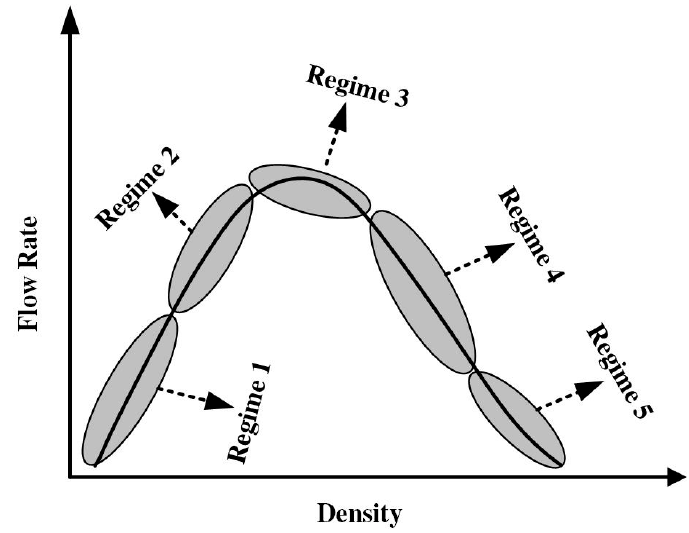
Figure 2. Regimes defined in the traffic fundamental diagram.